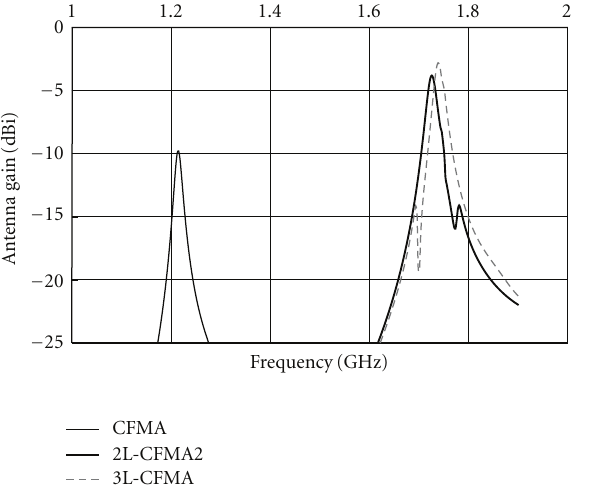
Figure 10: Simulated antenna gain characteristics.